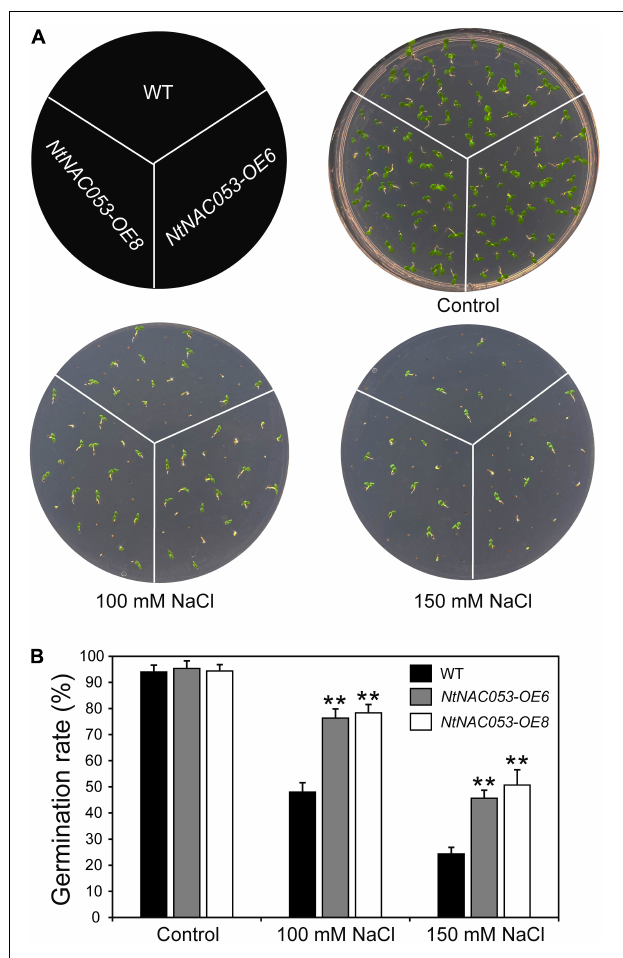
FIGURE 5 | Overexpression of the NtNAC053 gene promotes seed germination under salt stress treatments. (A) Seed germination assay between overexpression lines and wild type under NaCl treatments. (B) The statistics of seed germination under normal conditions and NaCl treatments. WT, wild type. The data were means ± SD from three independent replications. ** p < 0.01 ( t